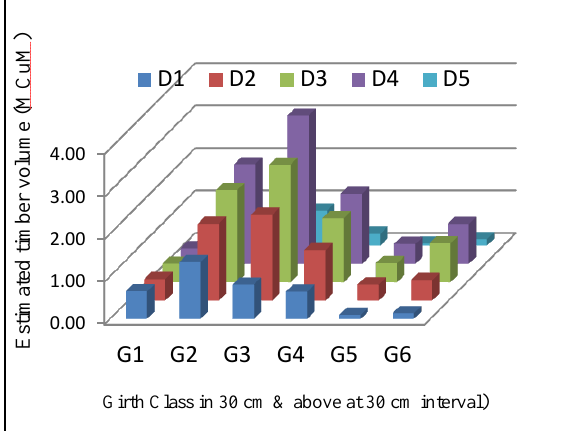
Figure 2. Estimated timber volume of Meghalaya state 3.1.2 Identifying potential areas for sericulture